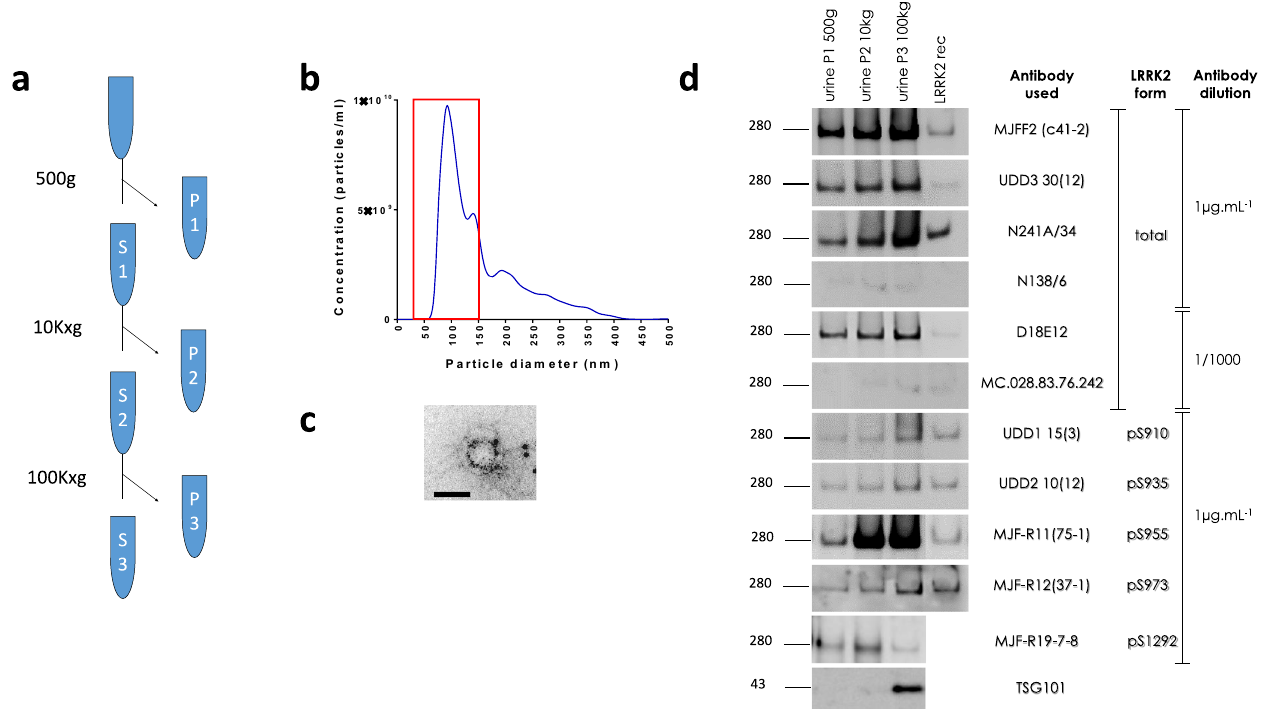
Fig. 1 Detection and characterization of LRRK2 and Rab epitopes in urinary exosome enriched extracellular vesicles (uEVs). a Flow diagram of the differential centrifugation protocol employed to isolate uEVs. The full method is described in detail in materials and methods. b Nanoparticle tracking analysis of extracellular vesicles isolated from urine according to the method schematized in ( a ) (sample P3). c LRRK2 detection via immunogold labeling in negative stain transmission electron microscopy (TEM). The panel shows a TEM image of uEVs and dual immunogold labeling with anti-LRRK2 antibodies (RabMab UDD3 and Neuromab N241, revealed by large and small gold particles, respectively) illustrating LRRK2 labeling in uEVs. Scale bar, 100 μm. d Western blot detection of total and phospho-epitopes of LRRK2 with multiple different antibodies, using different fractions of urine (pellet fractions P1, P2, and P3 as schematized in A) as well as recombinant LRRK2. The presence of the exosome marker TSG101 in P3 indicates that this fraction is enriched in